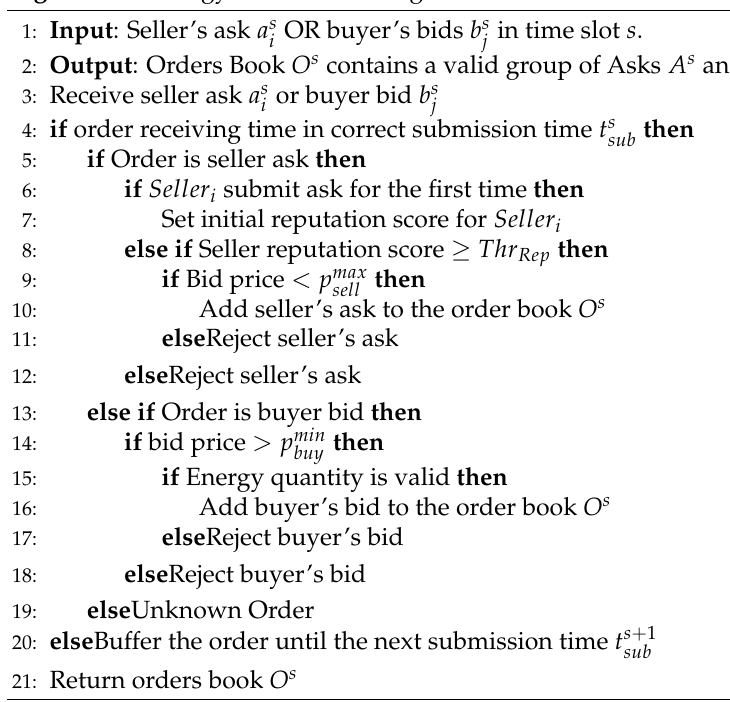
Algorithm 1 Energy Orders Handling and